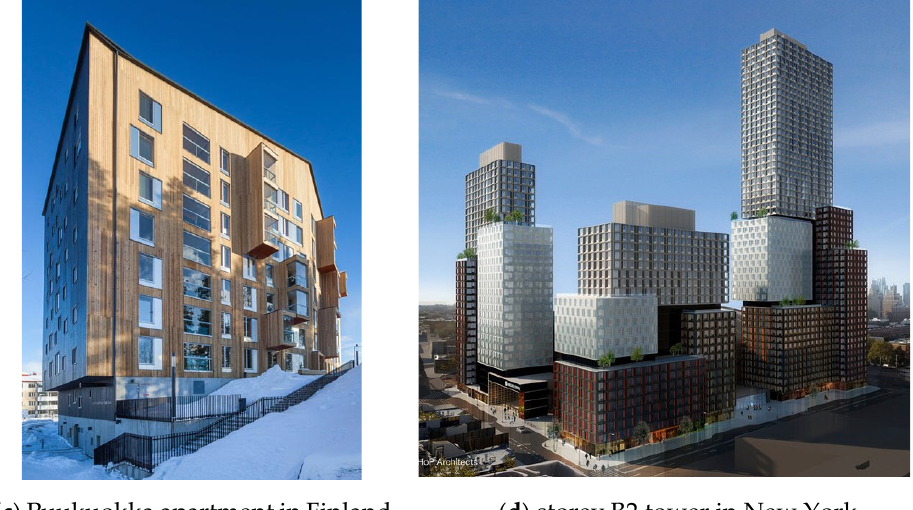
Figure 2. Different prefabricated and modular constructions.